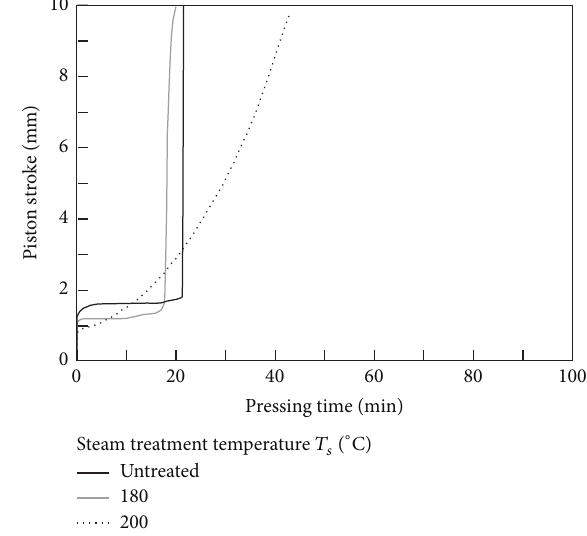
Figure 5: Effect of steam treatment temperature 𝑇 𝑠 on the thermal flow curve. ( 𝑡 𝑠 = 20 min and 𝑡 ℎ = 5 min).